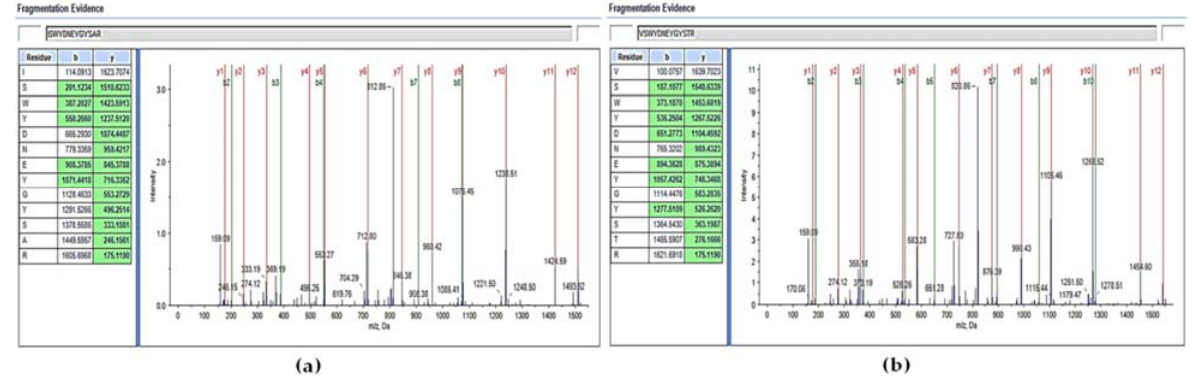
Figure 6. Tandem Mass Spectrometry spectra processed and analyzed using ProteinPilot™ software, of two Glyceraldehyde-3-phosphate dehydrogenase (GAPDH) derived peptides found in fraction 8 kDa obtained from S. cerevisiae ER fermentation supernatants. ( a ) peptide amino acids sequence ISWYDNEYGYSAR; ( b ) peptide amino acids sequence VSWYDNEYGYSTR.